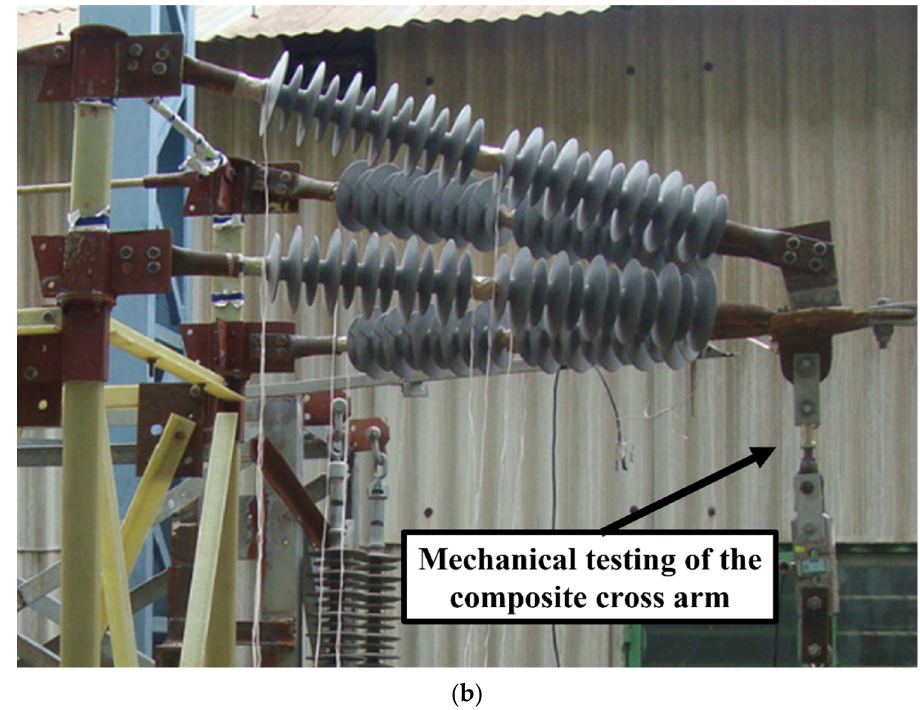
Figure 12. ( a ) The systematics of the test setup and ( b ) photograph of the composite cross-arm under mechanical testing [34].